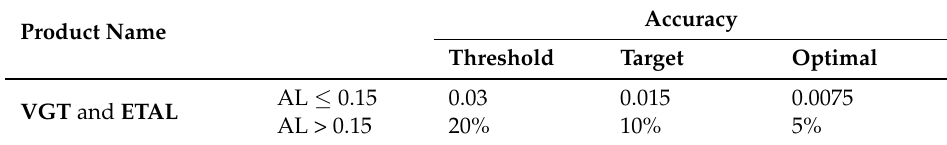
Table 5. LSA-SAF-based product requirements for ETAL and VGT SW-DH surface albedo products.